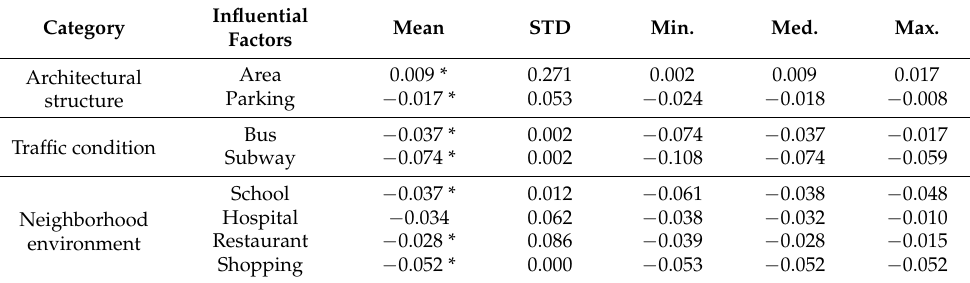
Table 7. The coefficient description of the MGWR